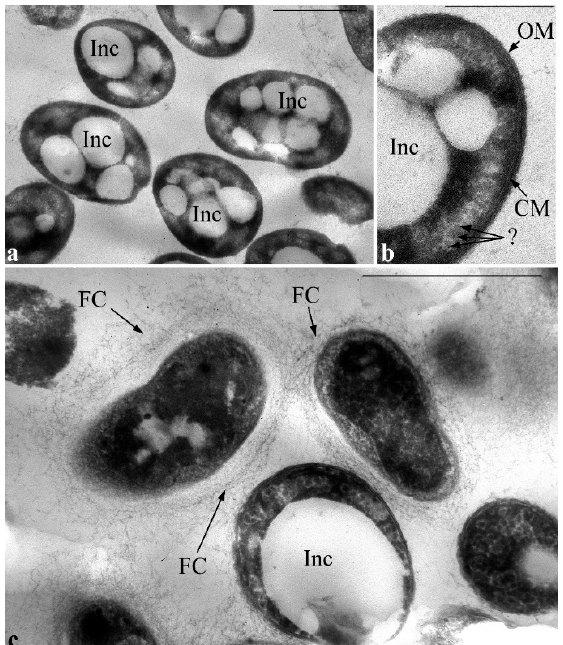
Figure 8. Transmission electron microscopy. Ultrathin sections of P. putida Ch 2 cells grown in a liquid MS1 medium with glyphosate: the 4th day of growth ( a , b ) and 8th day of growth ( c ). Designations: OM—outer membrane; CM—cytoplasmic membrane; Inc—PHA inclusions; FC—fibrillar cover. Mark “?” in image ( b )—inclusions of an unknown nature are indicated, resembling high-molecular starch-like compounds. Bar = 1 μ m